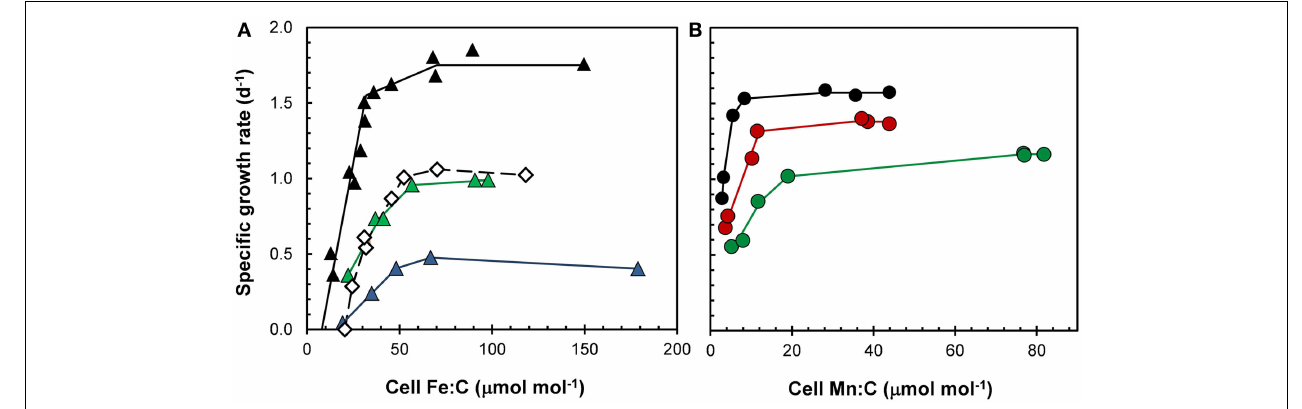
FIGURE 9 | Effect of light on cellular growth requirements for (A) iron and (B) manganese in the coastal diatom Thalassiosira pseudonana at 20˚C. (A) Relationships between specific growth rate and Fe:C molar ratio for cells growing under a 14:10h light:dark cycle at light intensities of 500 (black triangles), 85 (green triangles), and 50 (blue triangles) μ mol photons m − 2 s − 1 .